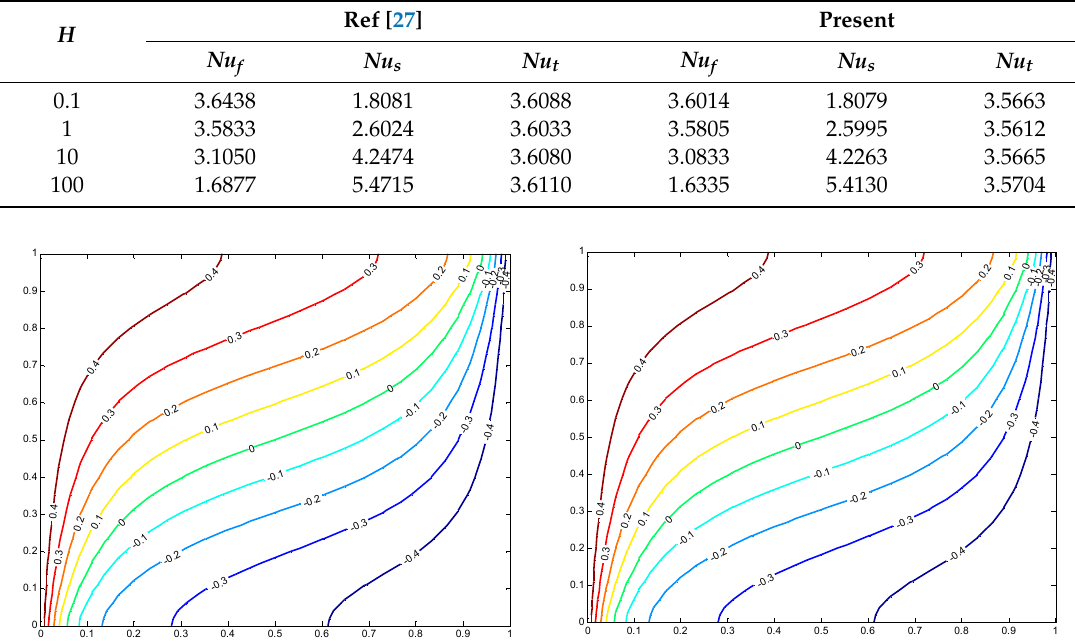
Figure 6. Isotherms for fluid (Left) and solid (Right) at the equilibrium condition, Ra = 100, R d = 0.5, Kr = 1000, H = 1000. Table 2. Validation of the average Nusselt number, for the equilibrium condition. Ref.